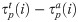
Examples of linear regression fits.The change of participant’s htp (the average time between two consecutive alternate touches) between the together period and alone-period (τpt(i)-τpa(i)), relative to the htp of the co-worker behavior in the same trial (τc(i)-Av(τpa)), where Av(τpa) represents the average undisturbed htp by a participant across all his/her participant-alone periods. Note that the (robot or human) co-worker htp was random across trials, and the data in plots here are the ensemble of the participant behaviors arranged in increasing co-worker’s htp on the abscissa. Each plot represent a condition, A) robot co-worker (blue); B) human co-worker (orange); C) robot covered co-worker (dark blue); D) human covered co-worker (dark orange); E) robot non-biol co-worker (cyan); F) robot indus co-worker (magenta) conditions. We used the AIC to choose either a first or second order model to fit the data for each participant. The lines represent the tangent slopes at the minimal data abscissa value.